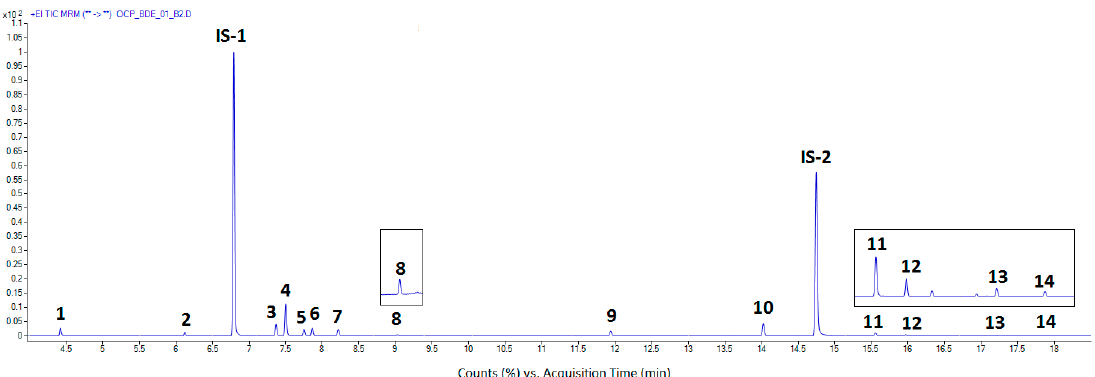
Figure 1. Total ion MRM chromatogram from the GC–QqQ-MS/MS analysis of the blank chub composite sample spiked with the test analytes at LOQ level of 0.1 µ g/kg, and internal standards at 10 (IS-1) and 20 µ g/kg (IS-2), respectively. Peaks: 1—hexachloro-1,3-butadiene,